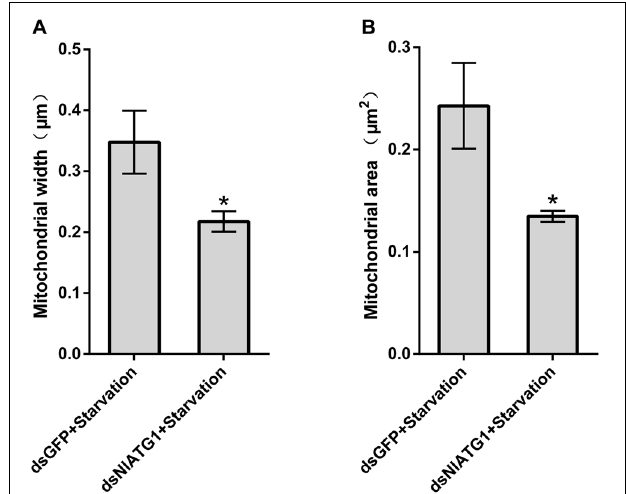
dsRNA and starvation. (A) mitochondrial width; (B) mitochondrial area. All values are presented as the means ± SD of three independent biological replicates (* p < 0.05). (Approximately 100 mitochondria were measured per replicate).